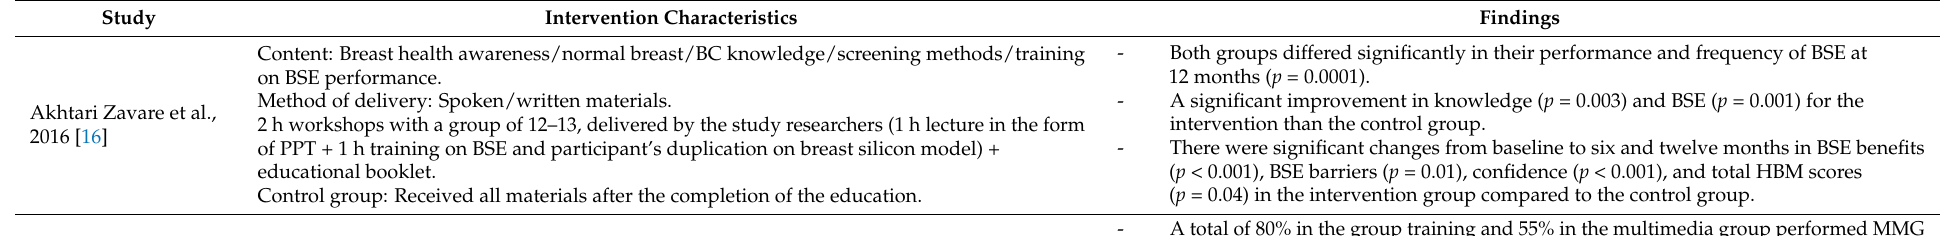
Table 3. Intervention characteristics and